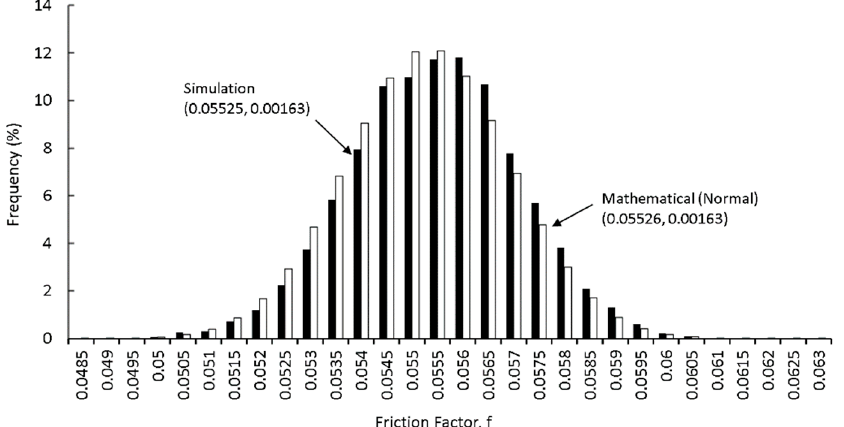
Figure 2. Comparison of the frequency distributions of analytical and simulation for the approxi- mation by Lamri and Easa